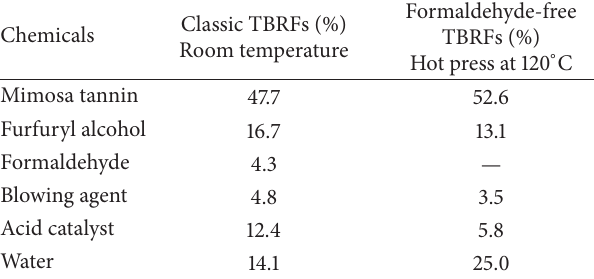
Table 1: Composition by weight of classic and formaldehyde-free tannin based rigid